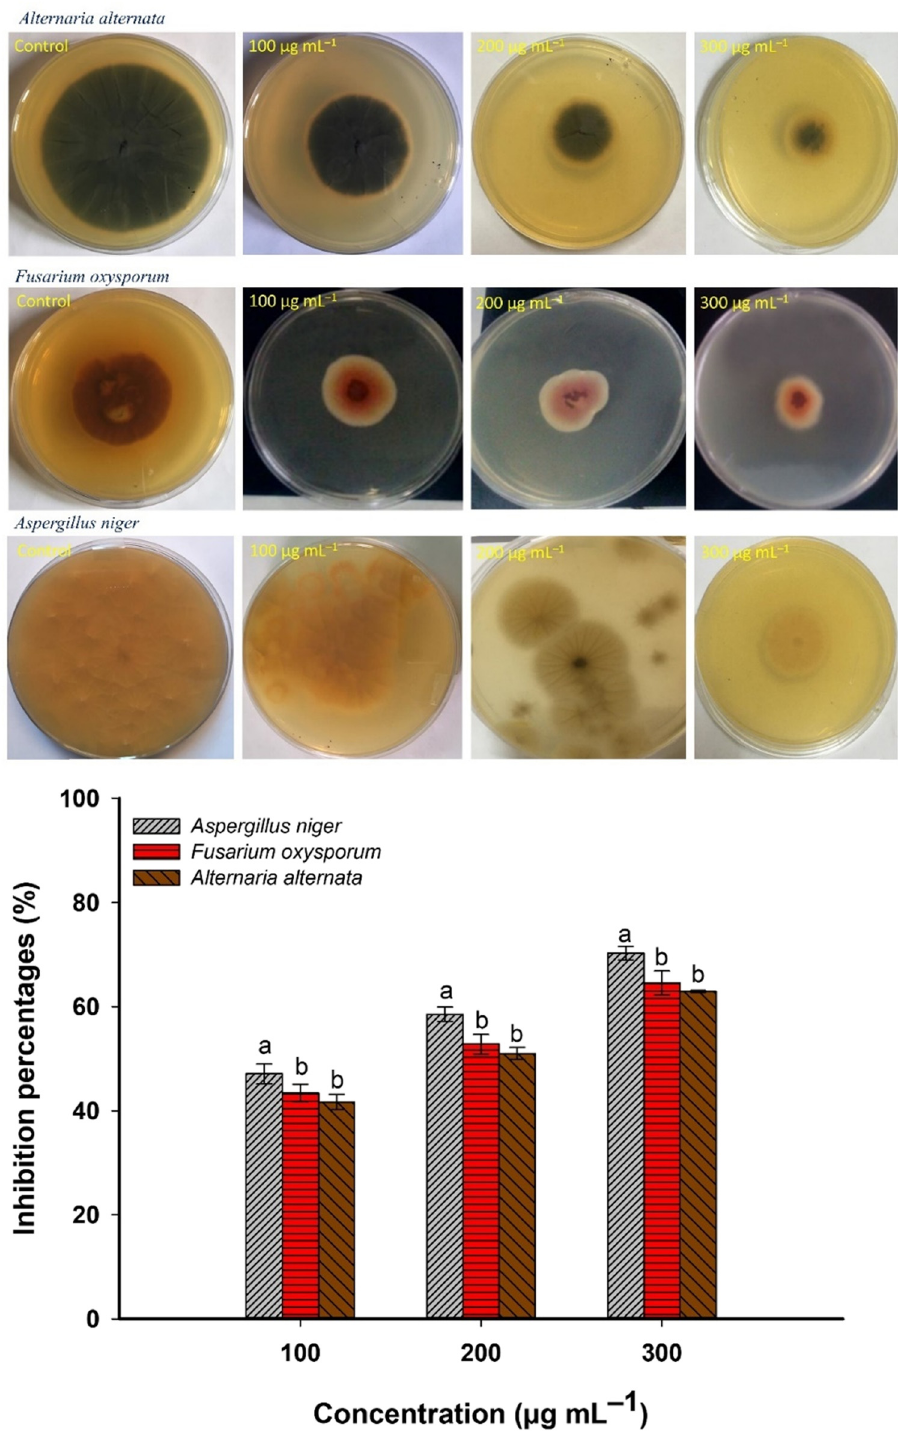
Figure 5: The mycelial growth inhibitions of three phytopathogens, F. oxysporum , A. alternata , and A. niger growing on potato dextrose agar media supplemented with di ff erent concentrations ( 300, 200, and 100 µg · mL – 1 ) and incubation for 5